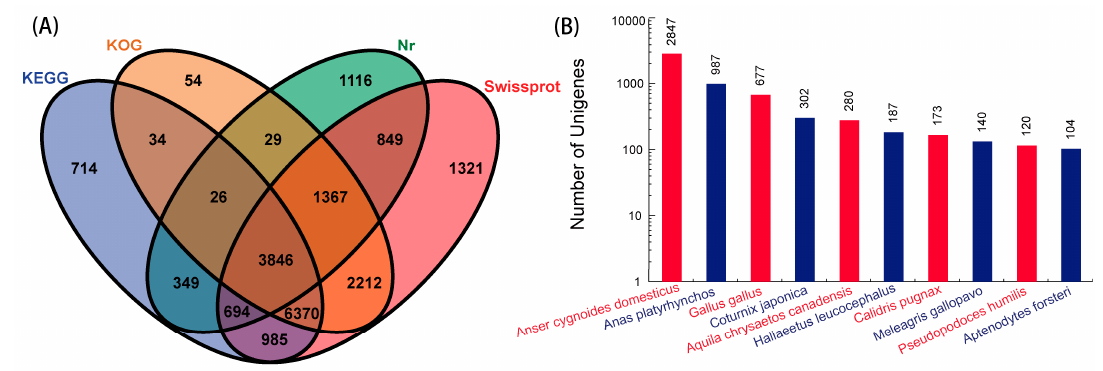
Figure 2. Characteristics of unigenes homology search in goose. ( A ) Venn diagram showed the number of unigenes annotated by BLASTx in different stages of feather follicle development, numbers in the circles indicate the number of unigenes annotated by single or multiple databases. ( B ) Number of unigenes matching to the 10 top species using BLASTx in the National Center for Biotechnology Information (NCBI) non-redundant (Nr)